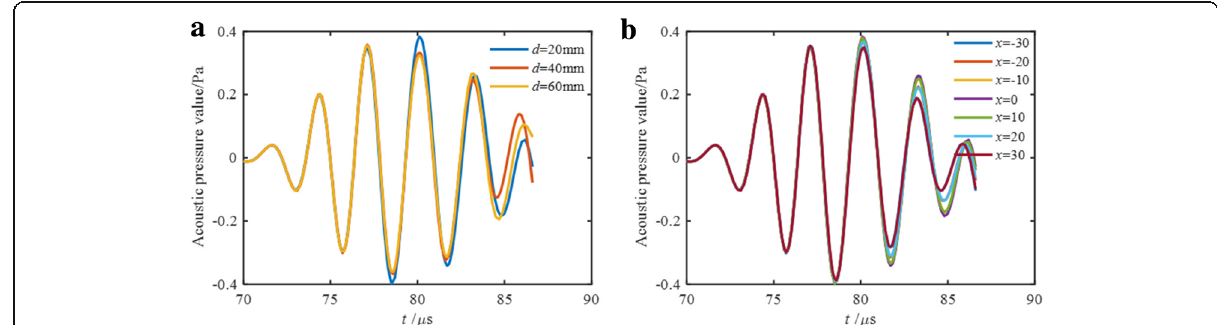
Fig. 5 The effects of the size and location of the gas bubble on received signal of direct ultrasound waves: a for different d of the gas bubble at the position (0, 0) and b for different positions of gas bubble from ( − 30, 0) to (30, 0) when d is 20